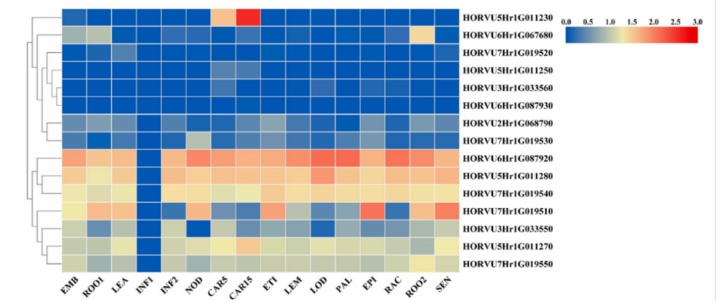
Figure 3. Heatmap of 15 candidate genes expression level in different tissues and developing stages. EMB: 4-day embryo, ROO1: Roots from seedlings (10 cm shoot stage), LEA: Shoots from seedlings (10 cm shoot stage); INF1: Young developing inflorescences (5 mm); INF2: Developing inflorescences (1–1.5 cm); NOD: Developing tillers, 3rd internode (42 DAP); CAR5: Developing grain (5 DAP); CAR15: Developing grain (15 DAP); ETI: Etiolated seedling, dark cond. (10 DAP); LEM: Inflores- cences, lemma (42 DAP); LOD: Inflorescences, lodicule (42 DAP); PAL: Dissected inflorescences, palea (42 DAP); EPI: Epidermal strips (28 DAP); RAC: Inflorescences, rachis (35 DAP);ROO2: Roots (28 DAP). SEN: Senescing leaves (56